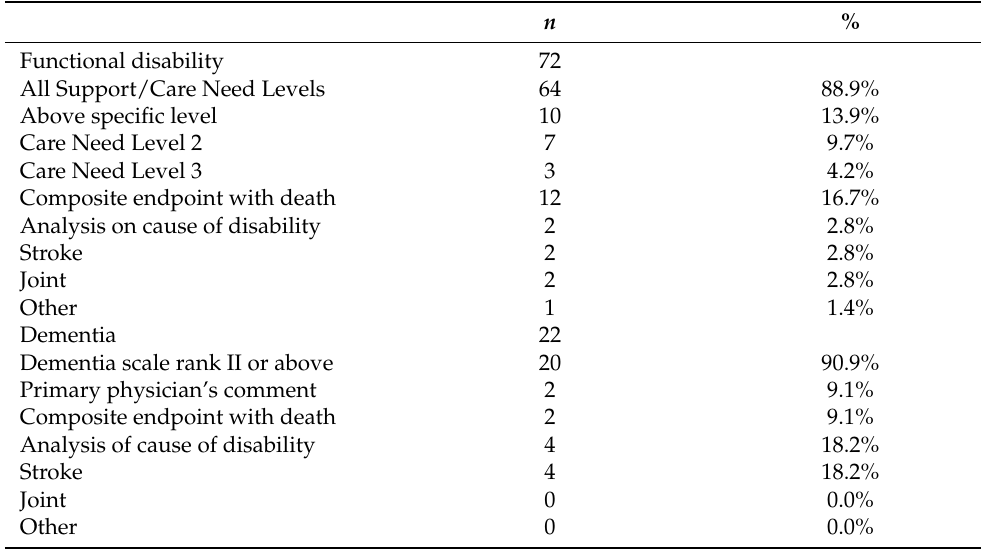
Table 1. Classification of endpoints in the reviewed articles.